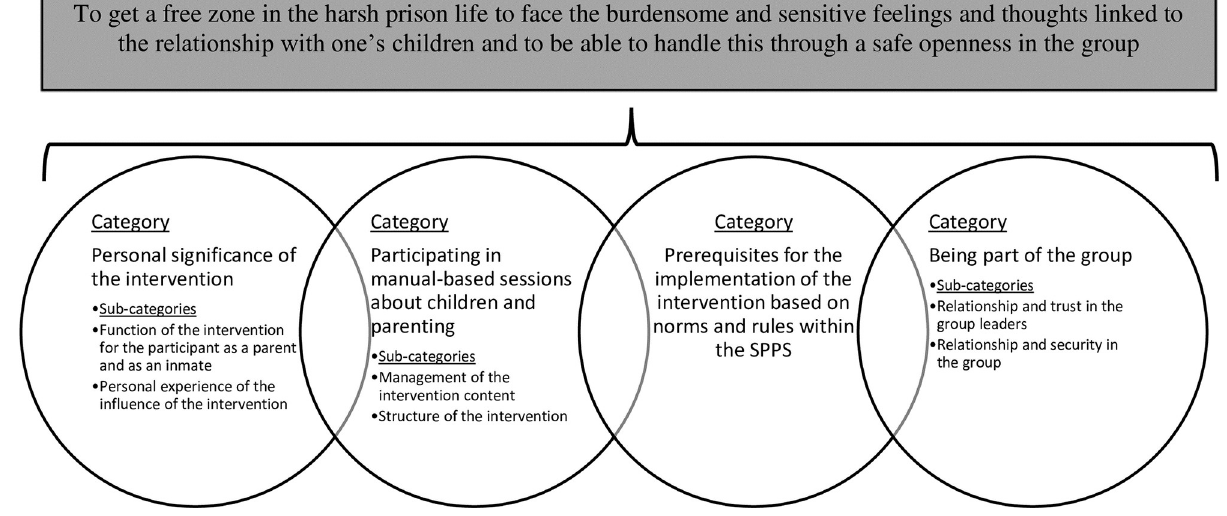
Fig 1. Figure displaying the latent overarching theme above manifest categories and